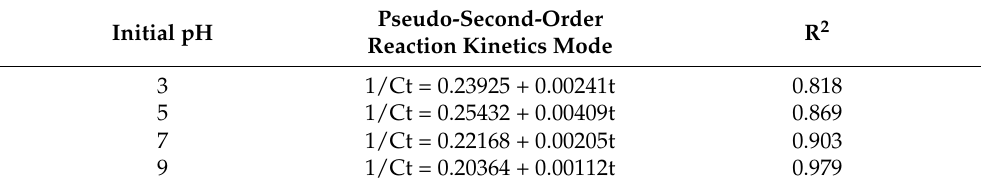
Figure 5. ( a ) The effect of pH on BPA removal; ( b ) The kinetic of of BPA degradation at different pH. Table 5. The kinetic parameters of BPA degradation at different pH.